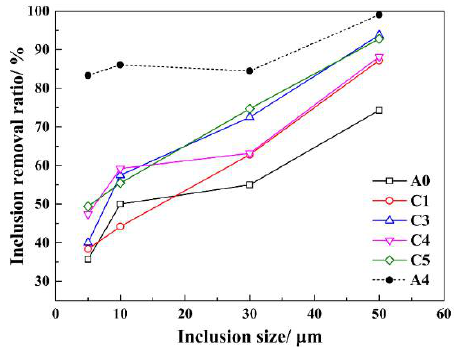
Figure 20. Comparison of removal ratios of different sizes of inclusions under various cases.